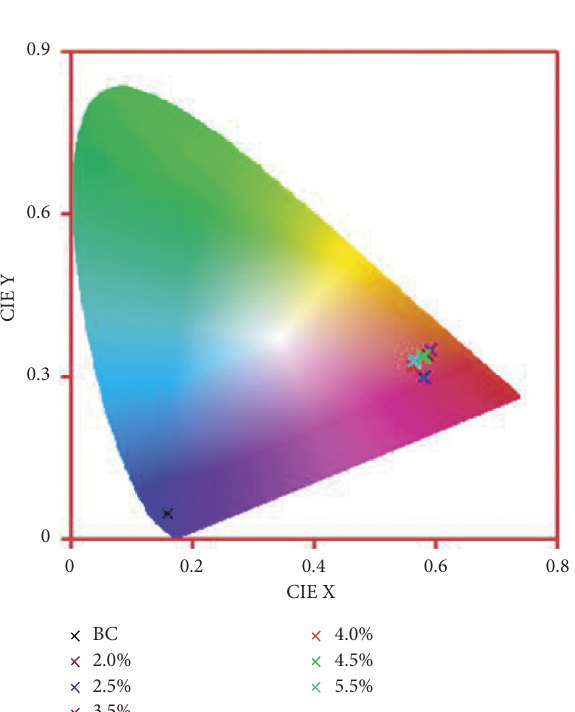
Figure 11: CIE chromaticity diagram for the BC and BC: x % Eu 3+ (0 ≤ x ≤ 5.5)